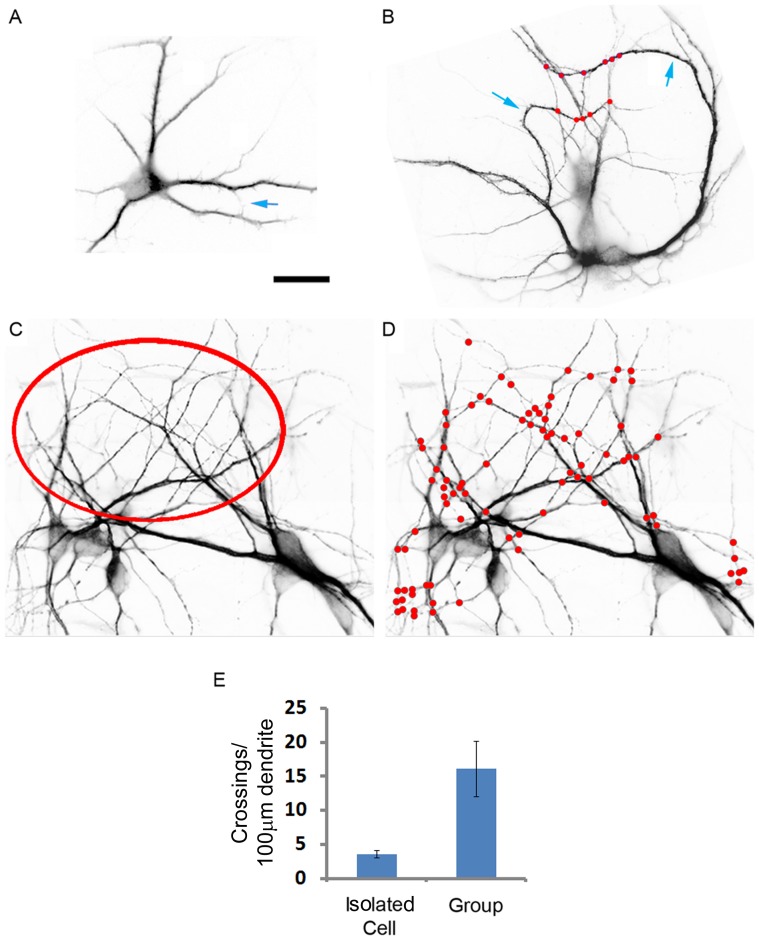
Neighboring dendrites preferentially generate contacts among their branches.Pictures are inverted images of hippocampal neurons grown in culture for 5 days and labeled with anti-MAP2 antibody. (A) An isolated neuron with no physical contacts with other neurons made a single contact between its own branches (arrow). (B) Within a neuronal assembly, dendritic branches turn (arrows) to contact branches of neighboring dendrites (red spots). (C, D) A dense culture in which all neurons orient dendritic branches toward a major overlapping area (circled) where heavy crossing takes place (D, red spots). (E) Dendrite-dendrite contact density is significantly higher among grouped rather than isolated neurons. Shown is the mean ± SEM. Scale: 20 µm.